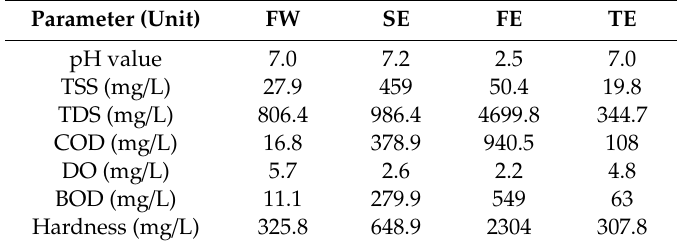
Table 3. Physical and chemical properties of all types of effluent studied in the present work.